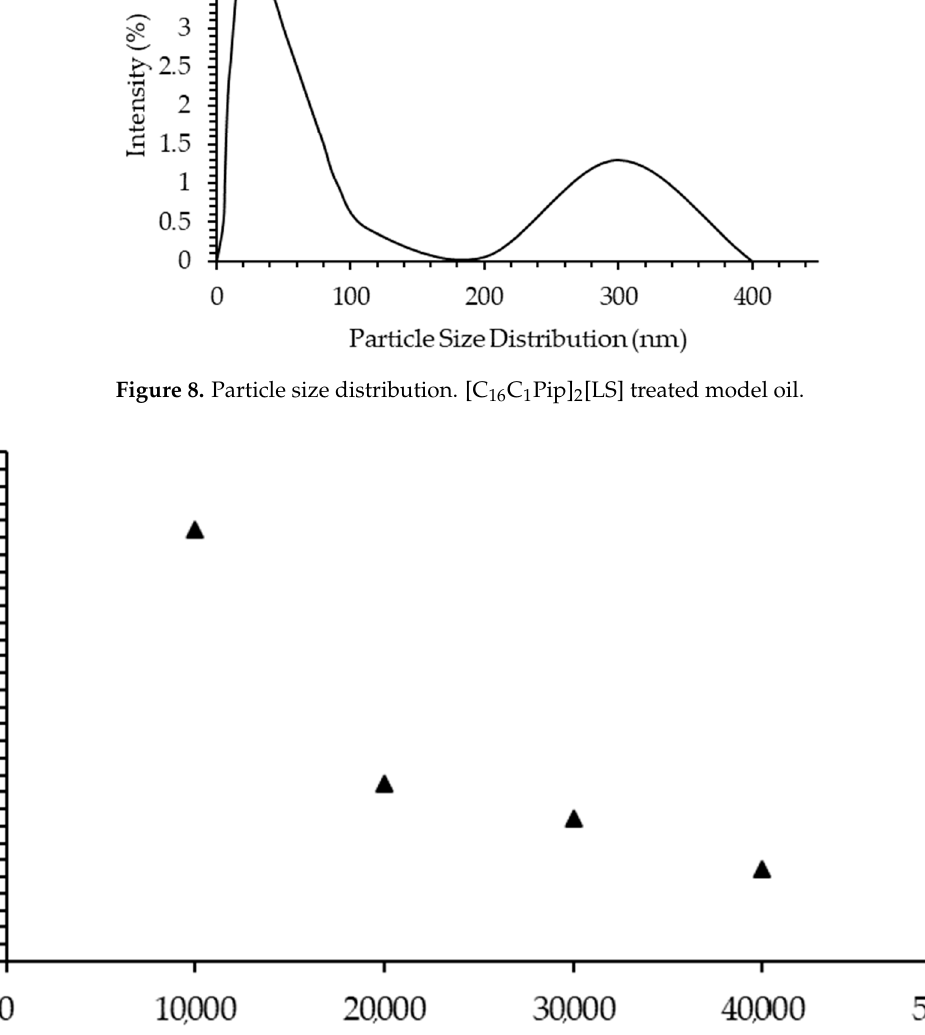
Figure 8. Particle size distribution. [C 16 C 1 Pip] 2 [LS] treated model oil.